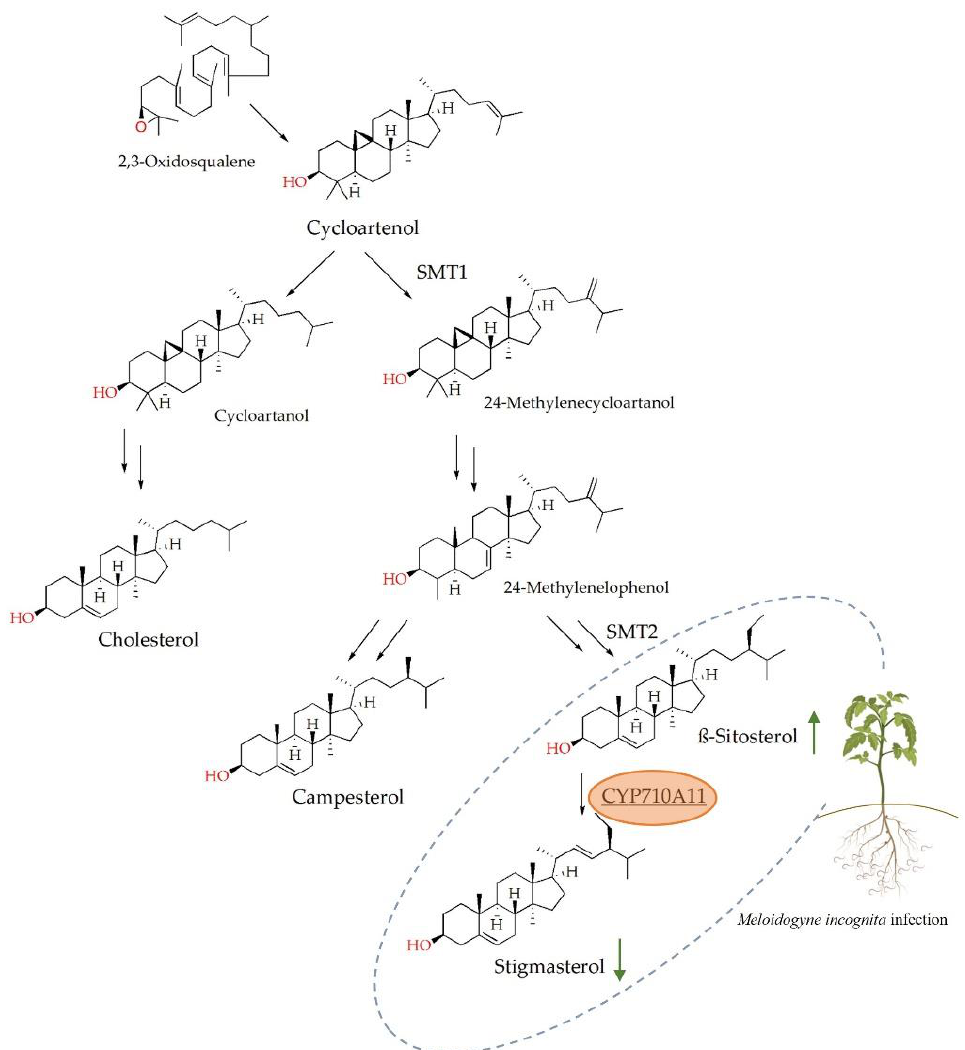
Figure 1. Cycloartenol sterol biosynthesis pathway up to the main plant sterols, campesterol, β -sitosterol, stigmasterol and cholesterol. The biosynthesis pathway of the C-24 alkyl phytosterols is characterized by the alkylation of the side chain by sterol methyltransferase (SMT) 1 and 2. The synthesis of stigmasterol from β -sitosterol is catalyzed by a single enzymatic reaction of a sterol C-22 desaturase in Solanum lycopersicum by the cytochrome P450 710A11 (CYP710A11) enzyme (highlighted in orange). Single arrows indicate one enzymatic step, while double arrows indicate multiple enzymatic steps. The green arrows show the changes in the β -sitosterol to stigmasterol ratio caused by M. incognita infection and are represented in the gray dotted area.